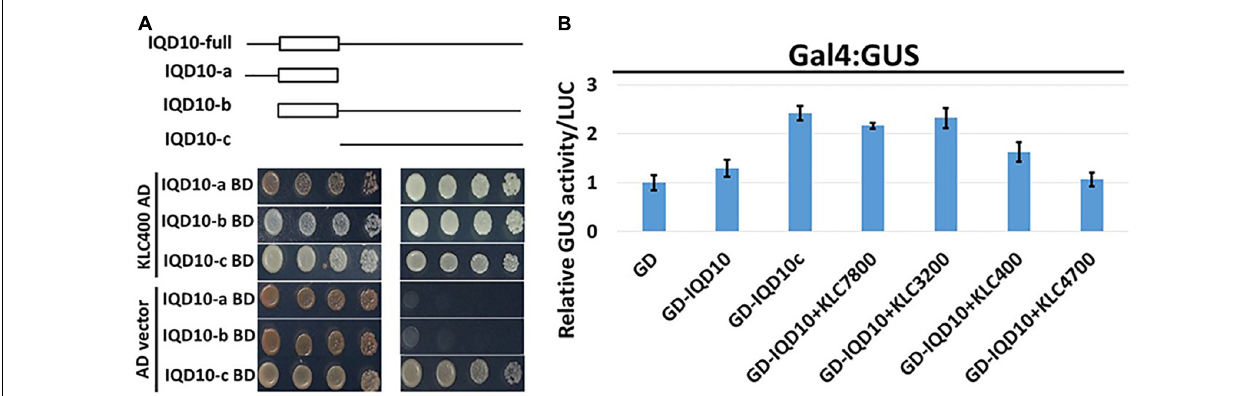
FIGURE 10 | Domain split analysis of PdIQD10 using transactivation assay. (A) Yeast two-hybrid analysis of PdIQD10 domains with KLC400 indicates the possible interaction of KLC400 with IQD10a and IQD10b fragments. Also, the empty vector AD control transfection with split PdIQD10 domains in BD shows autoactivation indicating its transactivation functions. (B) Protoplasts co-transfected with Gal4 :GUS reporter construct with versions of PdIQD10 in GD-fused constructs, in combination or not with KLCs, show increase in GUS activities indicating increased transactivation activity of PdIQD10 upon interaction with KLCs.